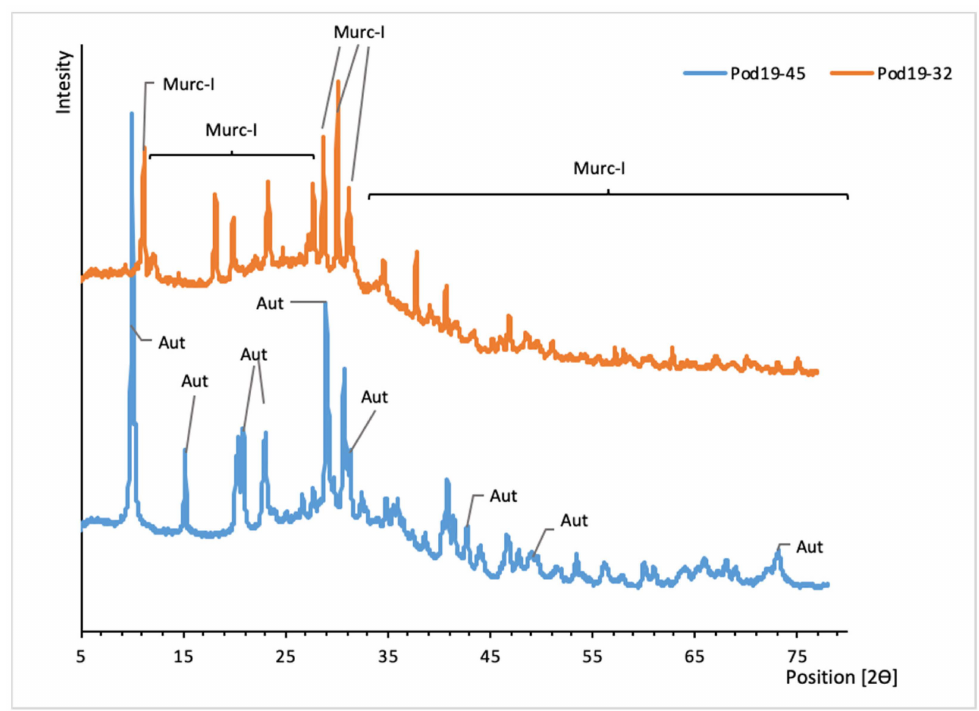
Figure 7. XRD patterns of uranyl phosphates from Podg ó rze mine. Aut, autunite; Murc-I, metauranocircite.